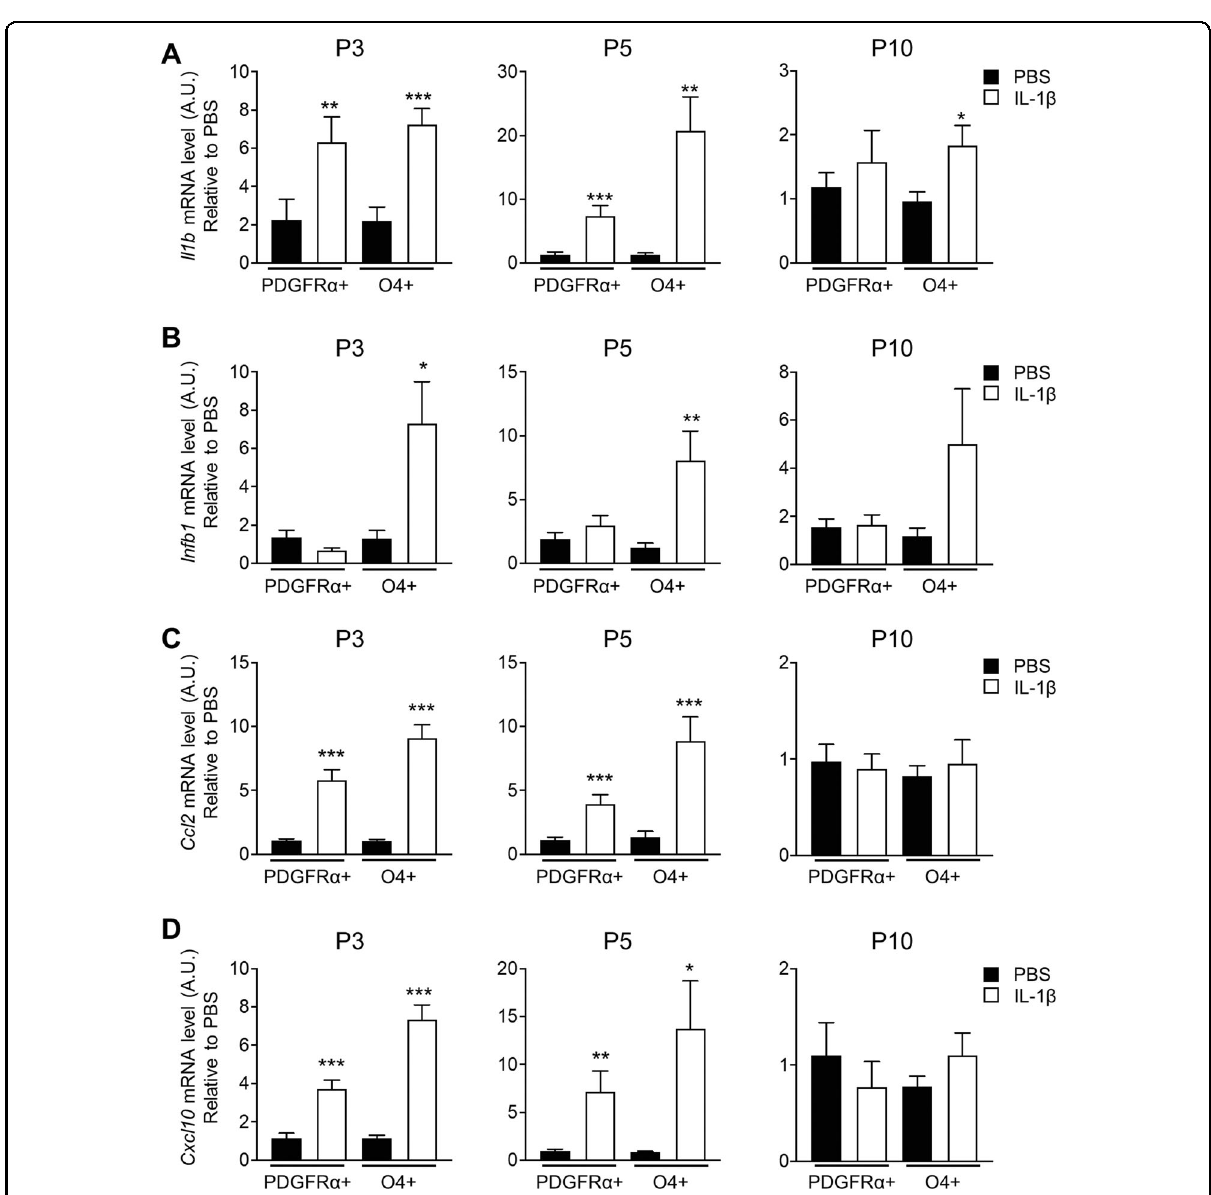
Fig. 3 Upon neuroin fl ammation the PDGFR α + OPCs and O4 + immOLs upregulate the expression of innate immunity related chemokines and cytokines. A – D Expression level of Il1b ( A ), Ifnb1 ( B ), Ccl2 ( C ), and Cxcl10 ( D ) assessed by qPCR in PDGFR α + OPCs and O4 + immOLs MACS- sorted from the brain of PBS and IL-1 β -treated mice at P3, P5, and P10 (data are mean ± SEM, n = 12 groups/condition from 2 independent experiments for P3 and n = 18 groups/condition from three independent experiments for P5 and P10, * P < 0.05, ** P < 0.01, *** P < 0.001 Unpaired t